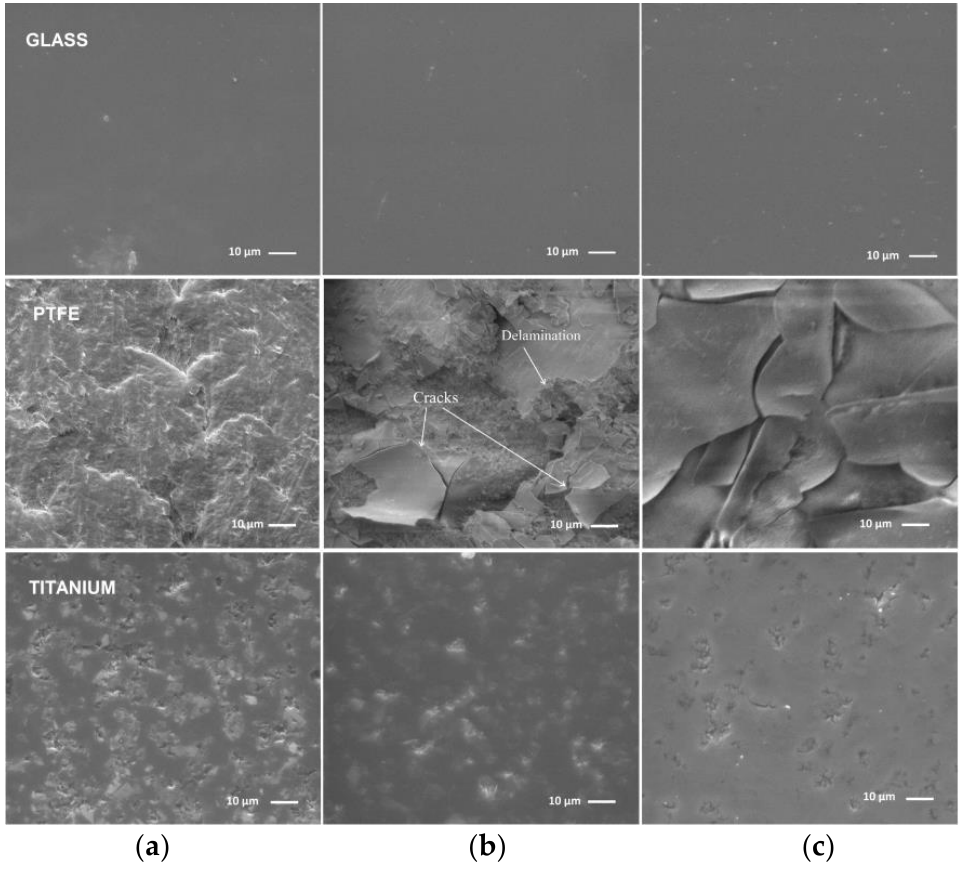
Figure 10. SEM images of the films on glass, PTFE and titanium deposited by the RF plasma jet: ( a ) Control, ( b ) Condition A, and ( c ) Condition B, respectively.